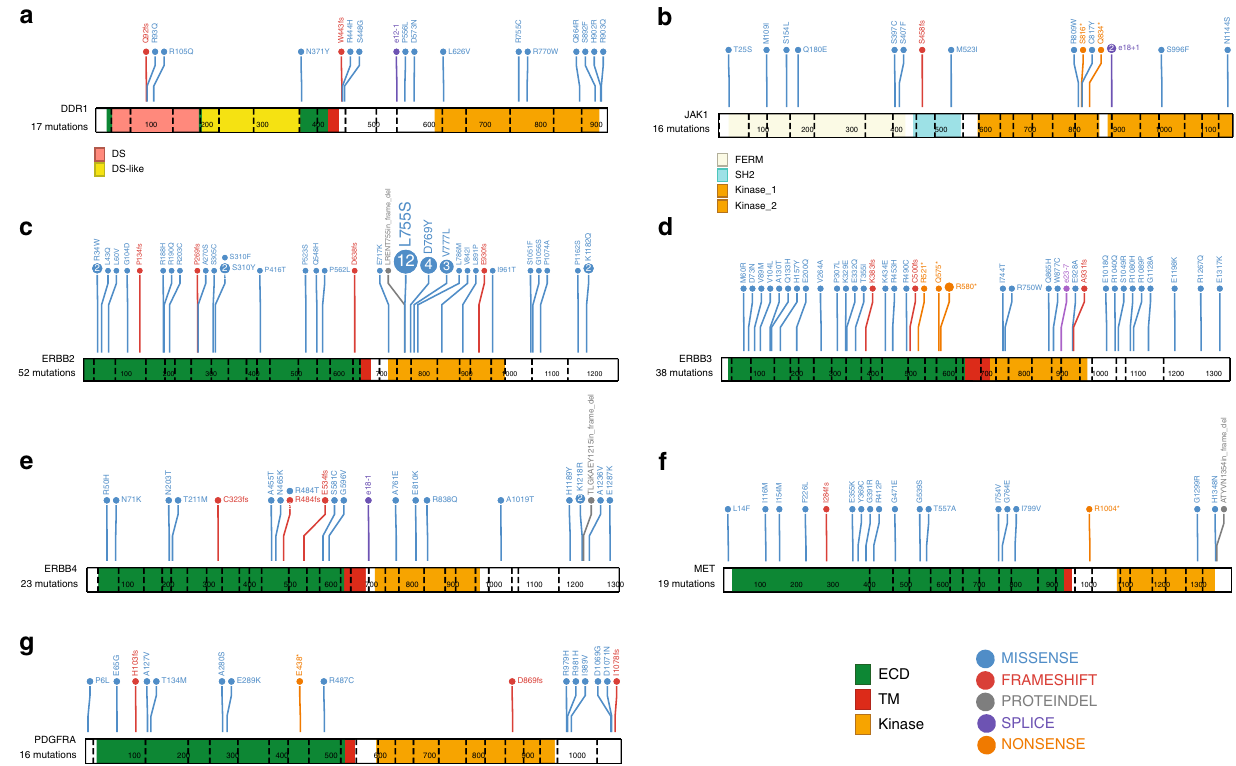
Fig. 8 Mutation pro fi les for selected genes. Mutation frequency plots illustrate all non-silent mutations (TAM, POLAR, and MA12; n = 1259) for representative transcripts for several kinase genes of interest. The domains belonging to a DDR1 (RefSeq ID: NM_013994) and b JAK1 (NM_002227) are indicated below the schematic diagram of each gene. The ECD (extracellular domain), TM (transmembrane domain), and kinase domain are depicted as green, red, and orange bars respectively for c ERBB2 (NM_004448), d ERBB3 (NM_001982), e ERBB4 (NM_005235), f MET (NM_000245), and g PDGFRA (NM_006206). The variant counts across the three data sets for each gene are provided below the gene ’ s name. Note, in the mapping from Ensembl (Supplementary Data 3) to RefSeq annotations (required for use of ProteinPaint tool) a small number of variants annotations may have changed or been lost, despite selecting the most similar representative transcript